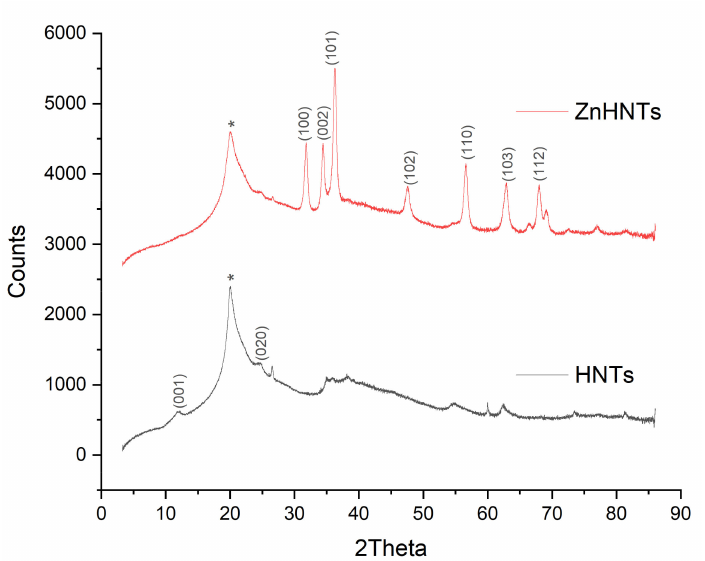
Figure 6. XRD profile of CS-HNTs and